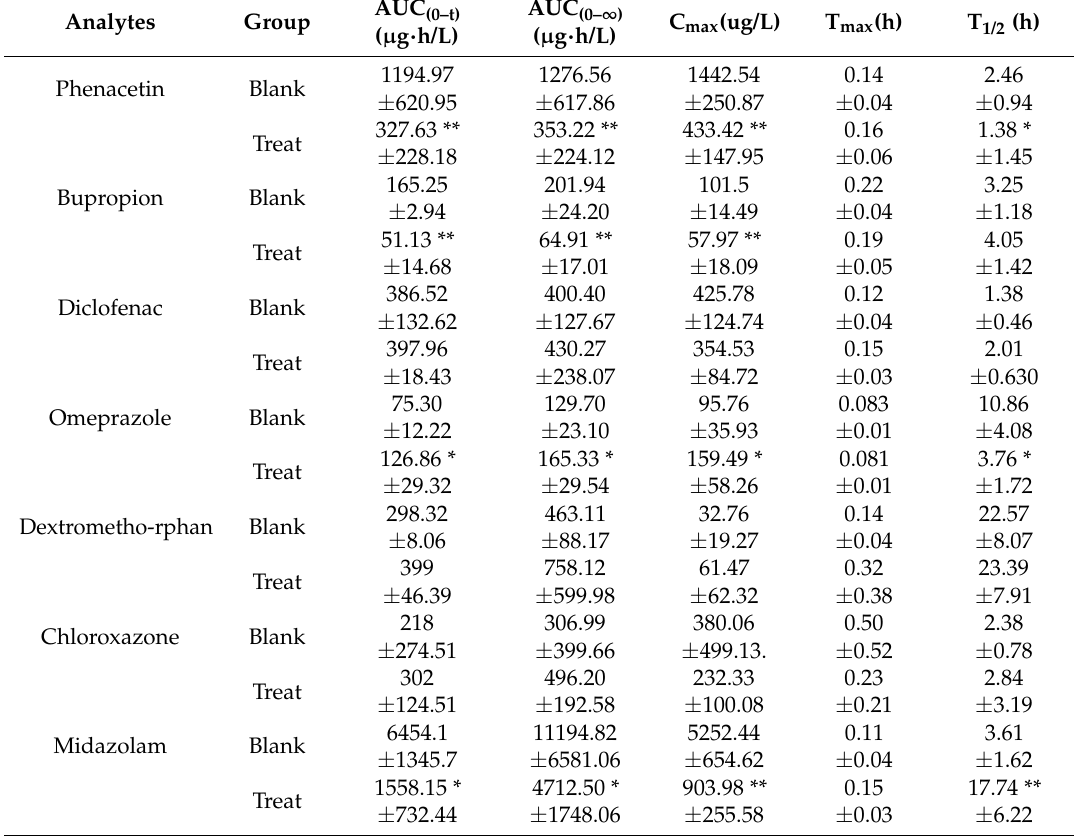
Table 5. Pharmacokinetic parameters of seven analytes in rat plasma after a single oral administration of a probe drugs solution in rats ( n =